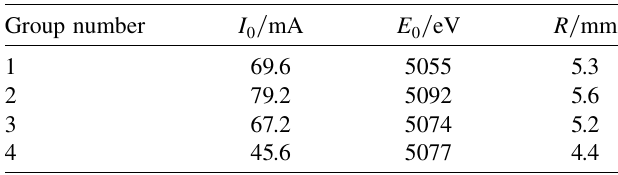
TABLE II. Beam parameter settings in WARP . Group